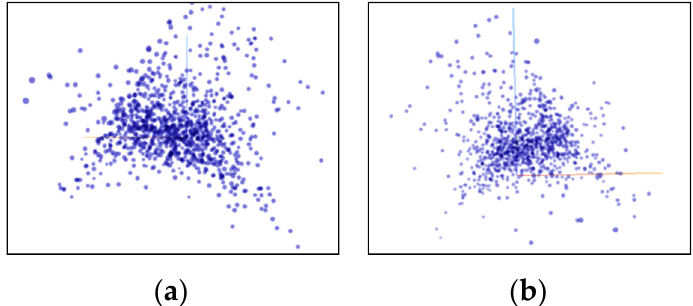
Figure 10. Use PCA to reduce the dimension to a 3D rendering. ( a ) x-y plane viewing angle; ( b ) y-z plane viewing angle.